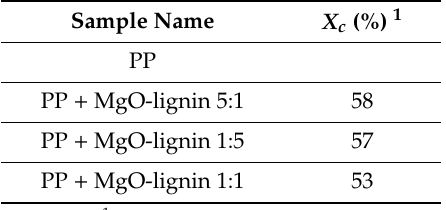
Figure 4. Wide-angle X-ray scattering (WAXS) patterns of composites. Figure 4. Wide ‐ angle X ‐ ray scattering (WAXS) patterns of composites. Table 3. Crystallinity degree of composite Table 3. Crystallinity degree of composite materials.